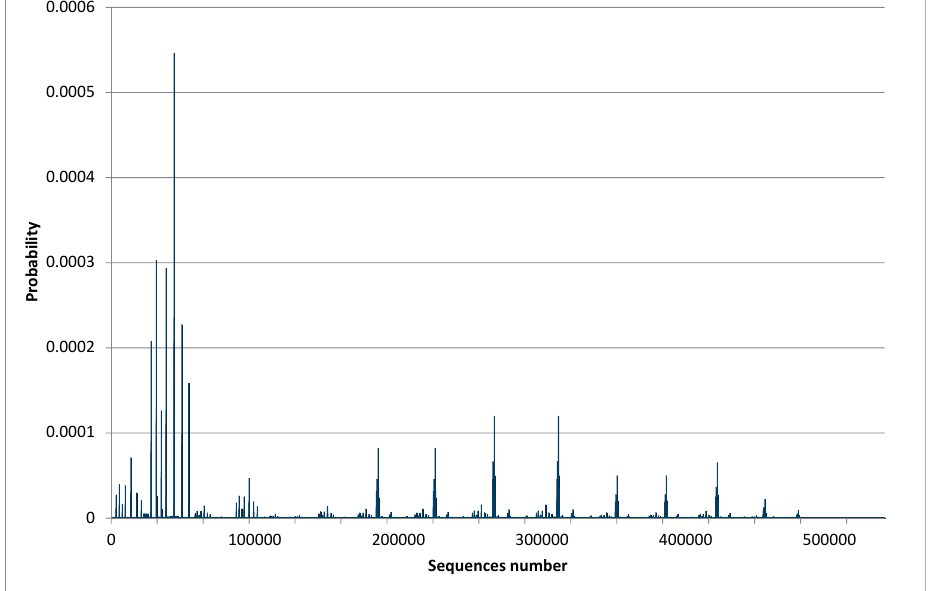
Figure 7. The probability of the sequences of events contain the high concentration of VOCs in the output for the reverse-flow based plant. Environments 2017 , 4 , 46